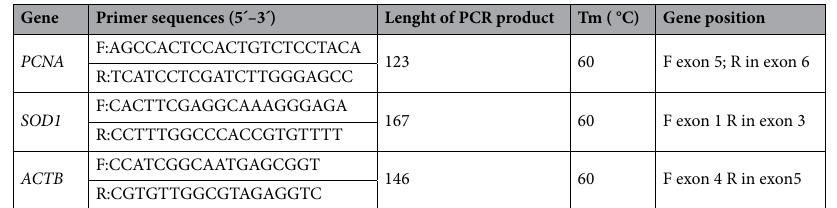
Table 3. Gene analyzed. Previous reported primers used in this study. Reference for gene: PCNA 27 , SOD1 27 , ACTB 28